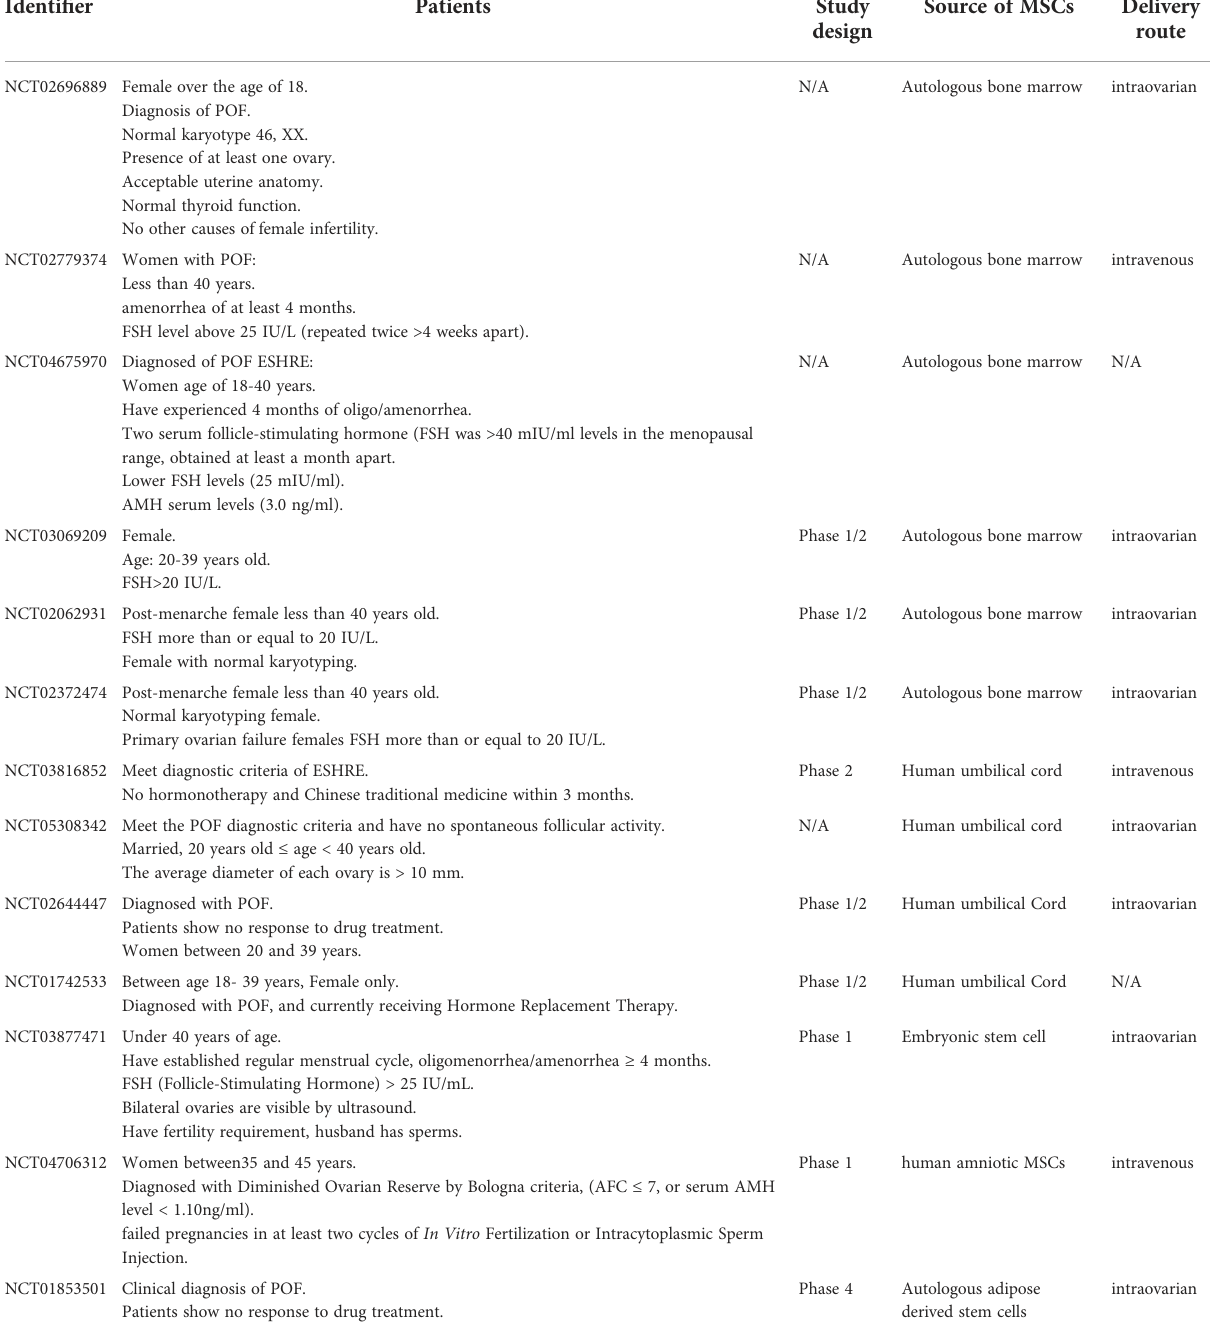
TABLE 5 Clinical trials of MSCs treatment for POF. Identi fi er